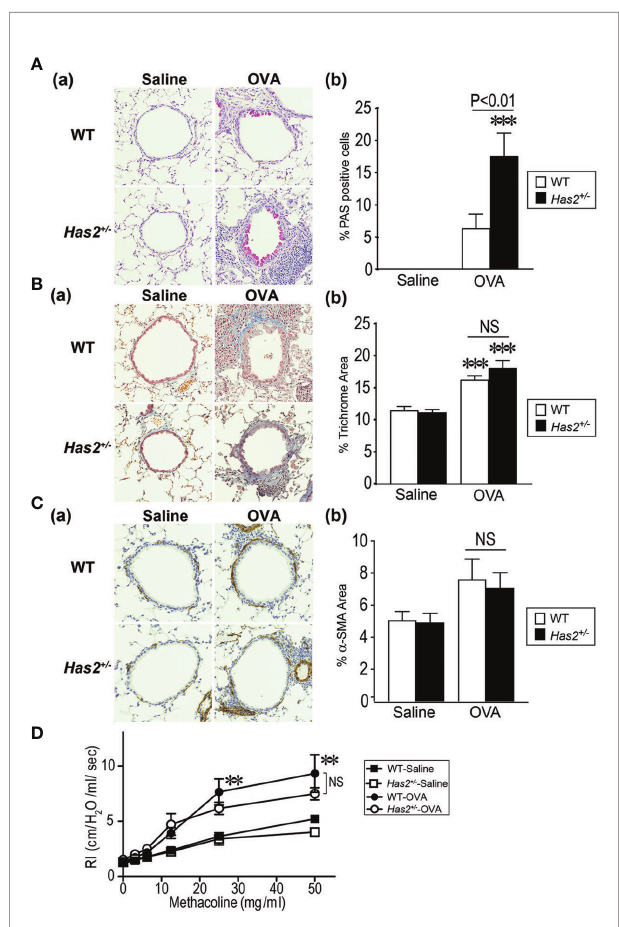
FIGURE 2 | Airway remodeling phenotype of Has2 +/ − mice after chronic OVA stimulation. (A) Periodic acid Schiff (PAS) stain in WT and Has2 +/ − mice (panel a ). Percentage of PAS-positive cells in the airway epithelium of WT and Has2 +/ − mice (panel b , n = 8 – 9). (B) Masson ’ s trichrome stain in WT and Has2 +/ − mice (panel a ). Percentage of trichrome staining area in the 20- m m region beneath the epithelium in the airways of WT and Has2 +/ − mice (panel b , n = 8 – 9). (C) Alpha smooth muscle actin ( ⍺ -SMA) stain in WT and Has2 +/ − mice (panel a ). Percentage of ⍺ -SMA staining area in the 20- m m region beneath the epithelium in the airways of WT and Has2 +/ − mice (panel b , n = 5). (D) Airway hyperresponsiveness to methacholine in WT and Has2 +/ − mice ( n = 5 – 9). All samples are obtained 24 h after the fi nal challenge with saline or OVA. Statistical signi fi cance is determined using Tukey ’ s multiple comparison test ( A – C , panel b ) or two-way ANOVA (D) . ** P < 0.01, *** P < 0.001 relative to the WT-saline mice. Horizontal bars indicate direct statistical comparisons between WT-OVA and Has2 +/ − -OVA mice. NS, not signi fi